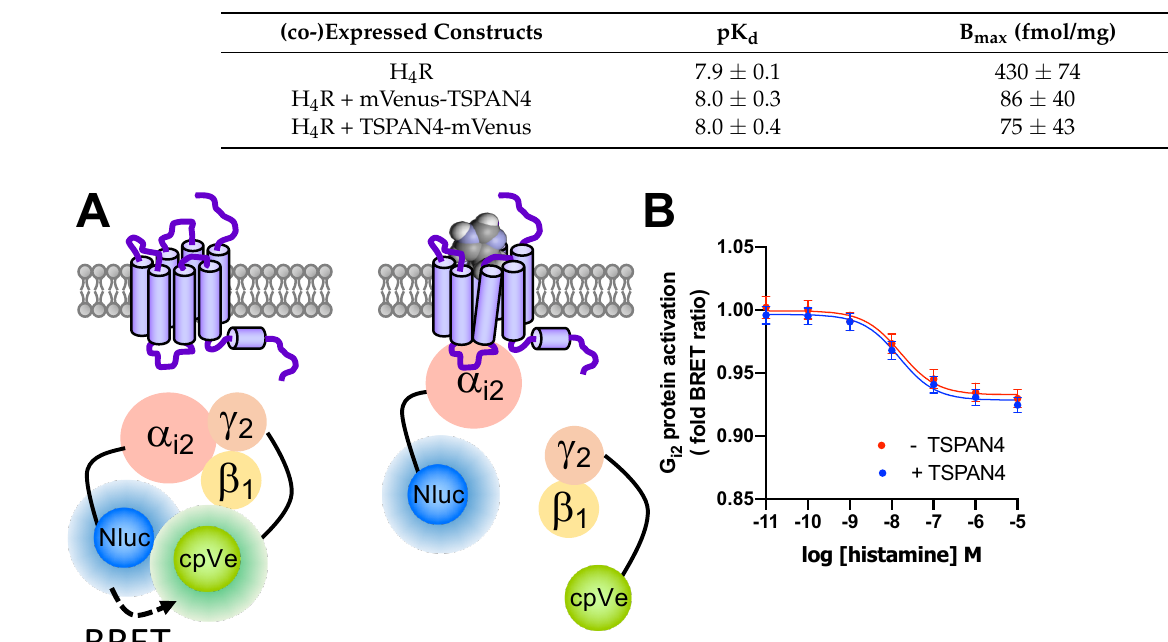
Table 1. Binding affinity of [ 3 H]histamine for H 4 R in cell homogenates in the absence or presence of TSPAN4. Data are displayed as mean ± SD from 5 independent experiments performed in duplicate.